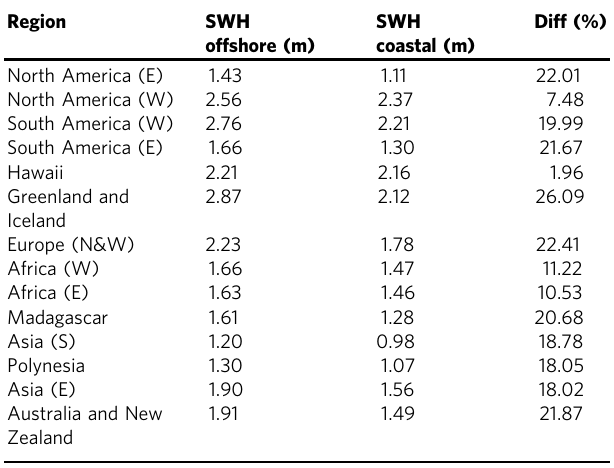
Table 1 Regional comparison of the mean SWH between offshore and